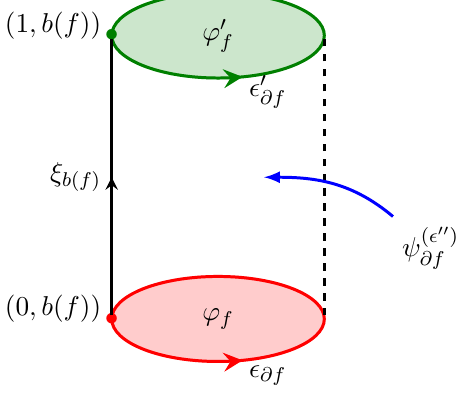
Figure 21 . The cylinder is given a cellular structure with two 0 -cells, indicated by bold dots. Three edges, indicated by solid lines, are mapped according to elements (cid:15) faces are given by bases of the cylinder and are mapped according to elements ϕ last face, based at (1 , b ( f )) , forms the lateral surface. It is mapped according to the element ψ ( (cid:15) 00 )